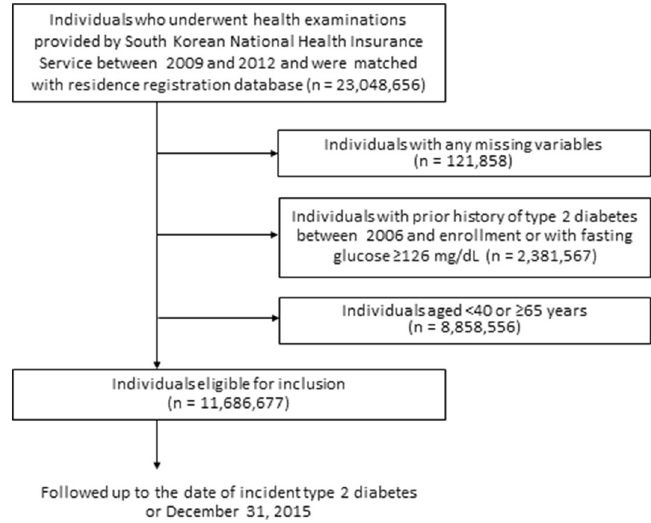
Figure 1. Flow chart of study